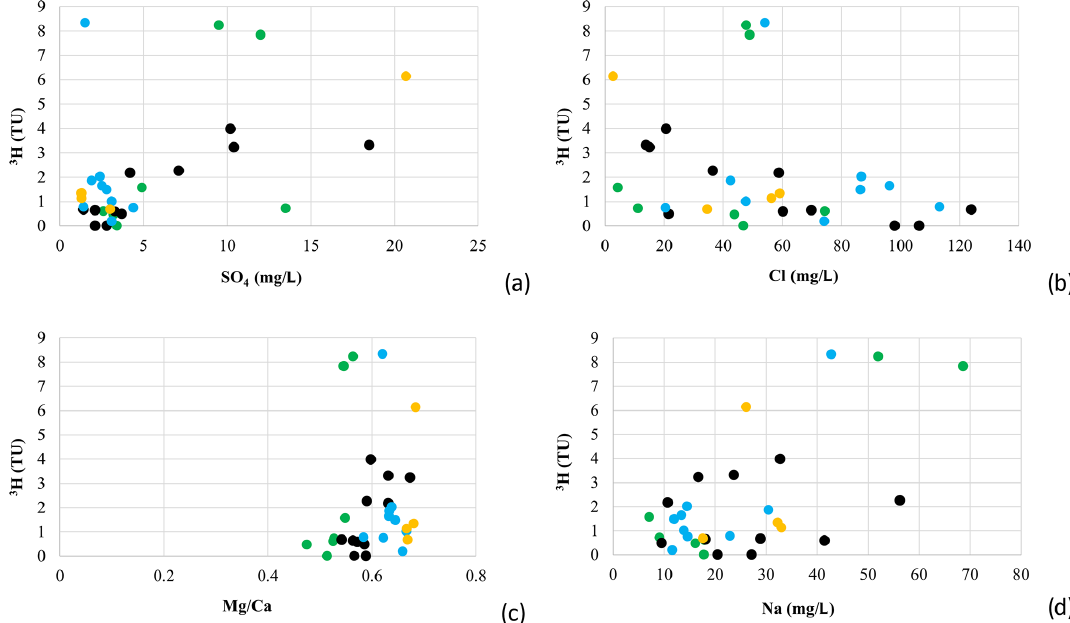
Figure 5. Correlation expressed in mgL − 1 between tritium and (a) sulphate; (b) chlorides; (c) ratio Mg / Ca; (d) sodium. Coloured in green the samples form Quinto di Treviso, in black samples from Treviso, in light blue samples from Preganziol and in yellow samples from Casier.